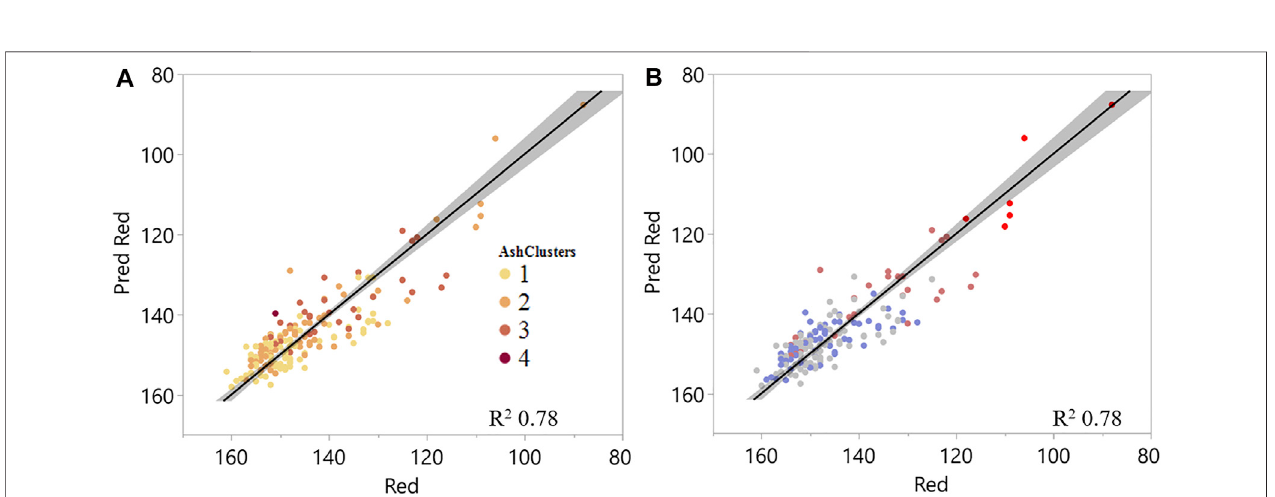
FIGURE 7 | Linear regression of measured versus predicted red channel value explained by chemical composition and select inorganic species (SO 3 and SiO 2 ) visualizing (A) ash clusters and (B) chemical clusters.